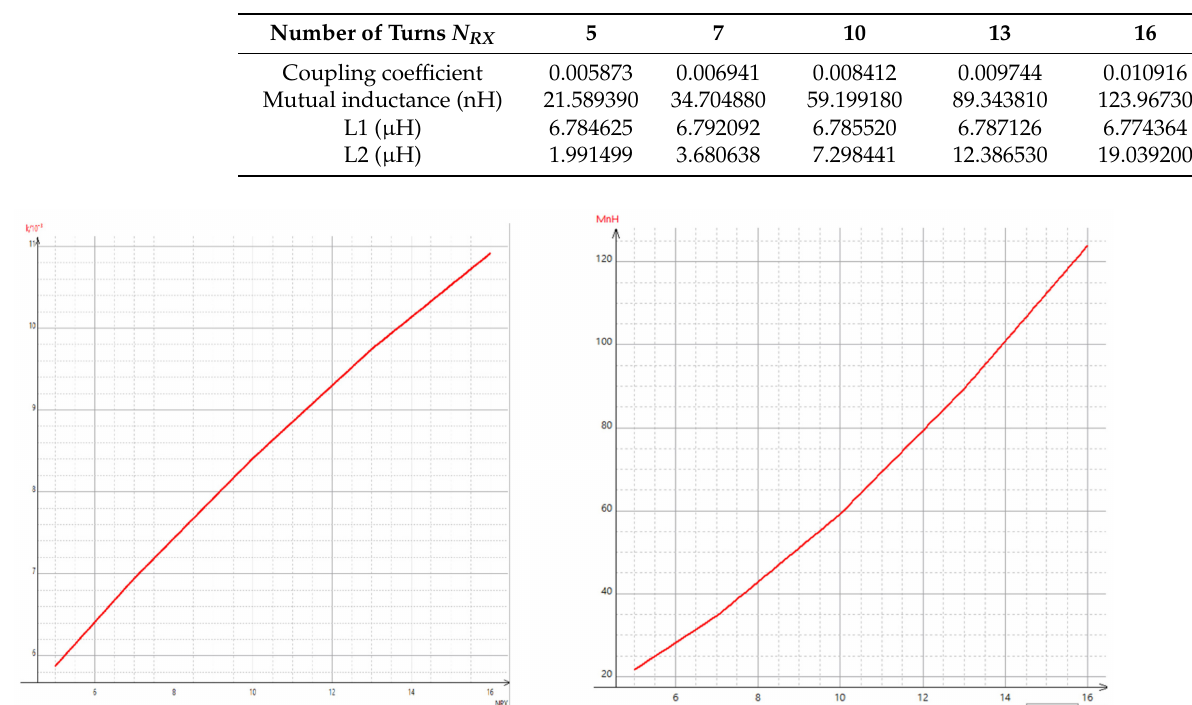
Table 8. Simulation results of circular coil model—number of turns N RX variation.